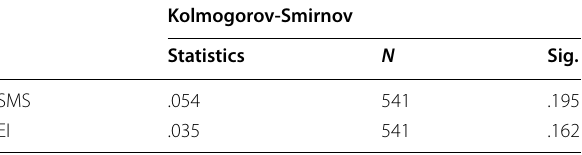
Table 1 Normality of the motivation scale and EI